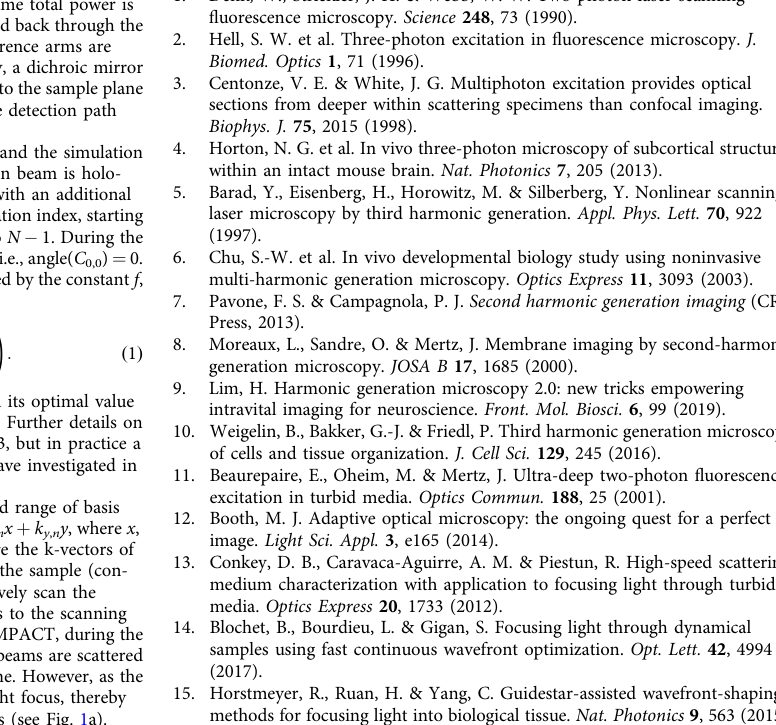
Fig. 1a, the excitation beam is sent through a beam splitter (BS, Thorlabs BS014) and the re fl ected beam is sent to an SLM (Hamamatsu X10468-07), which is imaged onto the entrance pupil of a water immersion objective lens (OL, Olympus XLUMPLFLN20XW, NA = 1) and the xy-scan galvos (Thorlabs GVS011) using 4f relays. Note that while a high resolution SLM display was used here, in general the number of SLM pixels does not need to exceed the number of corrected modes. The light transmitted through the beam splitter (about a third of the total power) is blocked while running the DASH algorithm, but for the F-SHARP experiments it is re fl ected off a combined tip/tilt and phase stepping scan mirror (Physik Instrumente S-325) to generate the scanning interferometer arm 38 . The laser power is increased slightly during the DASH algorithm so that the same total power is used for each approach. The excitation light is then either passed back through the beam splitter in the DASH con fi guration, or the scan and reference arms are interfered on the beam splitter in the case of F-SHARP. Finally, a dichroic mirror (DM) is used to direct the excitation light through the objective to the sample plane and subsequently to send the fi ltered fl uorescence signal to the detection path where it is measured using a PMT (Hamamatsu H10682-210). The principle of the DASH algorithm is outlined in Fig. 1a and the simulation code is included in the Supplementary Materials. The excitation beam is holo- graphically split by the SLM into a modulated wavefront M n with an additional phase shift φ p and a reference fi eld C i , n , where i denotes the iteration index, starting at i = 0, and n is the mode number, which is stepped from 0 to N − 1. During the = 0. fi rst measurement, the phase of the reference fi eld is set to zero, i.e., angle( C 0,0 ) The two fi elds are given a speci fi c intensity weighting, determined by the constant f , by displaying the following phase pattern on the SLM: